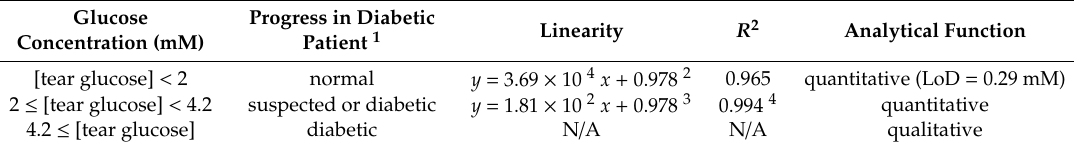
Figure 5. Quantitative data from tear-glucose assay using artificial samples (black dot), which is fitted to a sigmoid function with high correlation (black line, R 2 = 0.997) and linear regression at low-concentrations (blue line, R 2 = 0.965). Two red dash lines mean of the maximal plateau and the central piecewise linear approximation by the inflection point (red dot). Table 1. Analytical performance of paper-based tear-glucose assay.